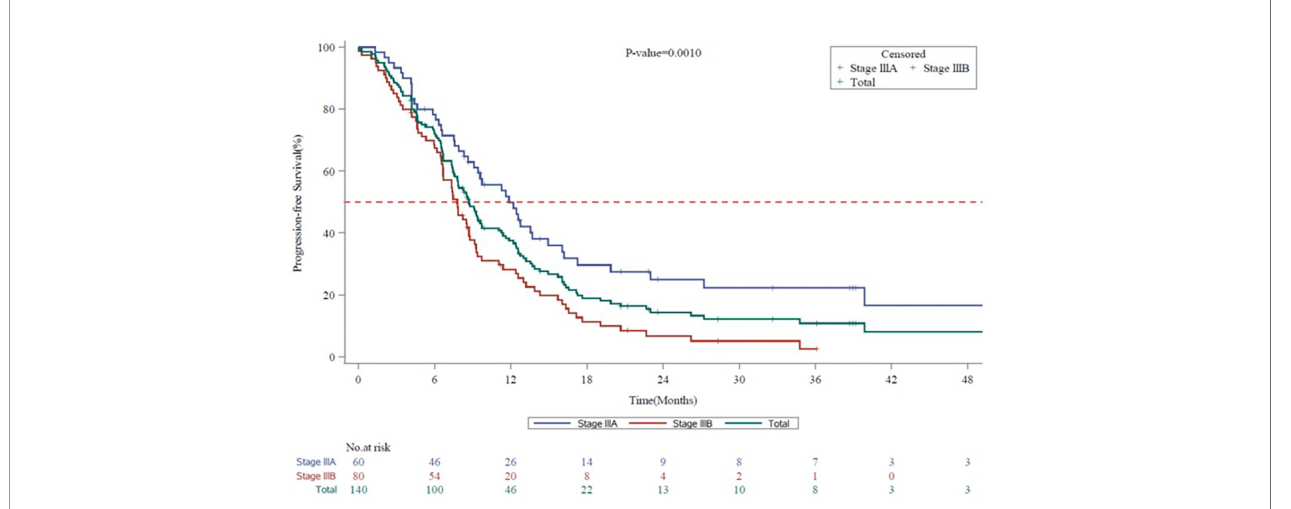
FIGURE 2 | Kaplan-Meier Survival Curves for Progression-free Survival by Disease Stage (7 th Edition AJCC) in Vietnam. AJCC, American Joint Committee on Cancer; CI, con fi dence interval; mPFS, median progression-free survival. Kaplan-Meier Survival curves for progression-free survival for all stage III NSCLC patients are shown in green, whereas stage IIIA and stage IIIB patients are shown in blue or red, respectively. mPFS for the entire Vietnam cohort, 8.7 months (95% CI, 7.59 to 9.72). mPFS for stage IIIA, 11.9 months (95% CI, 8.64 to 14.95). mPFS for stage IIIB, 7.8 months (95% CI, 6.64 to 8.71).